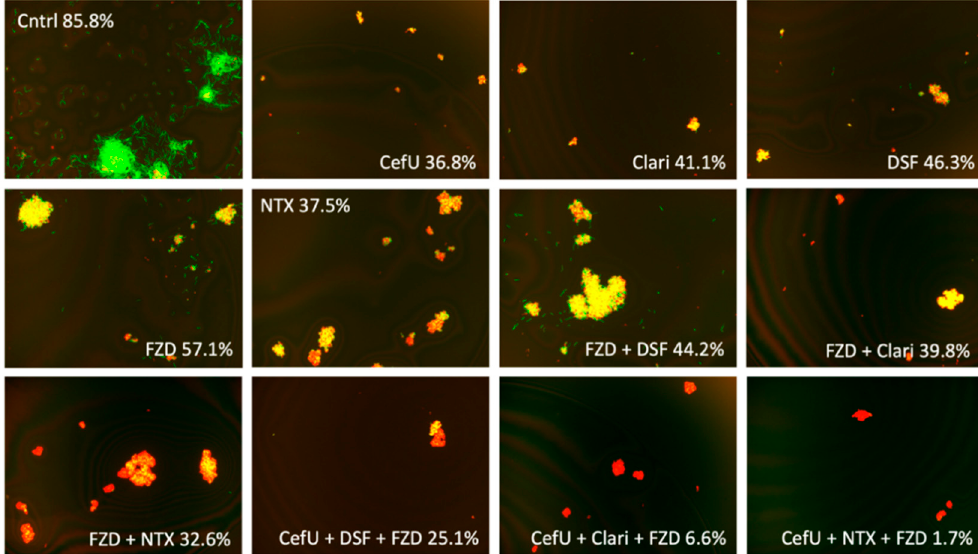
Figure 2. Effect at Cmax concentration for combinations with DSF, Clari, and NTX. Abbreviations: untreated control (Cntrl), cefuroxime (CefU), clarithromycin (Clari), disulfiram (DSF), furazolidone (FZD), nitroxoline (NTX).